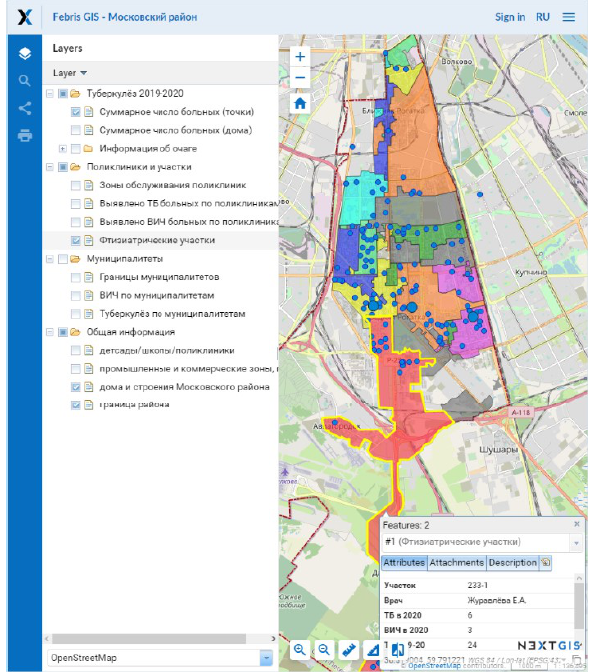
Figure 9 . Example of data representation on the febrisgis.ru .